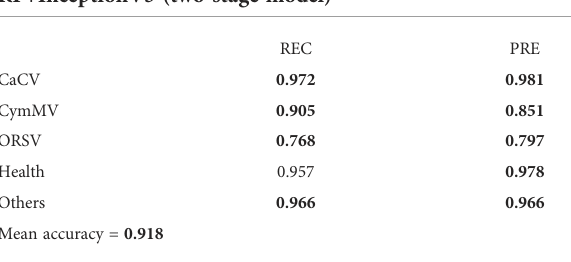
TABLE 5 Identi fi cation performances (the recall, precision and mean accuracy) of the proposed two-stage